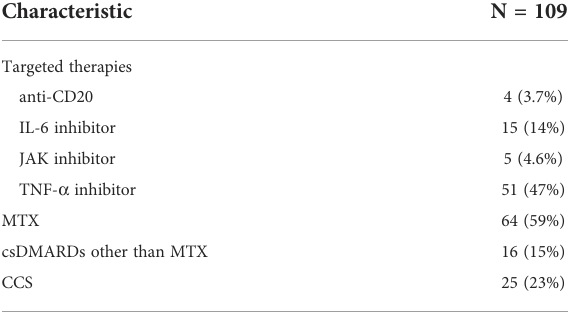
TABLE 2 Treatments by drug